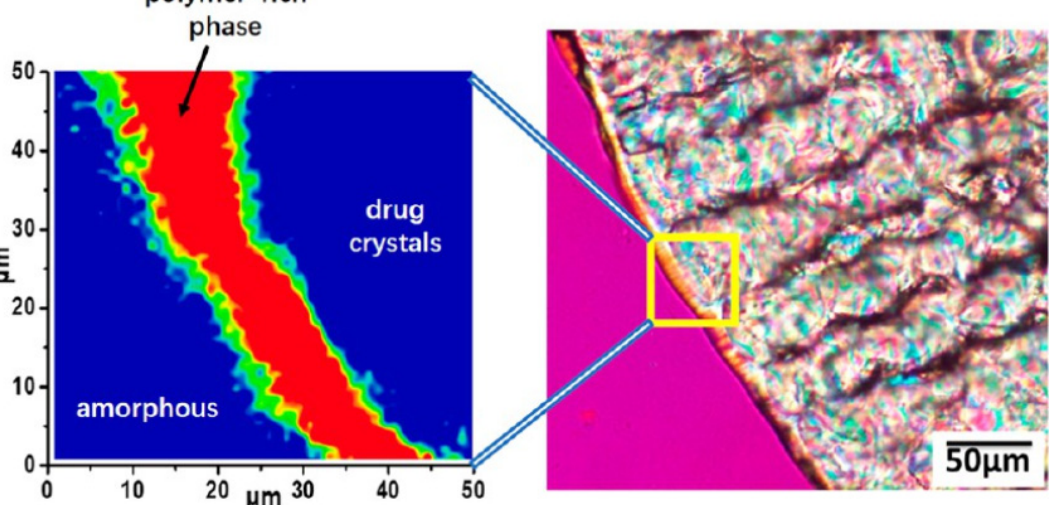
Figure 6. Raman mapping and photomicrograph of crystal growth front of GSF in griseofulvin–PEO binary system. Adapted from Ref. [55] with permission. Copyright © 2019 American Chemical Society.